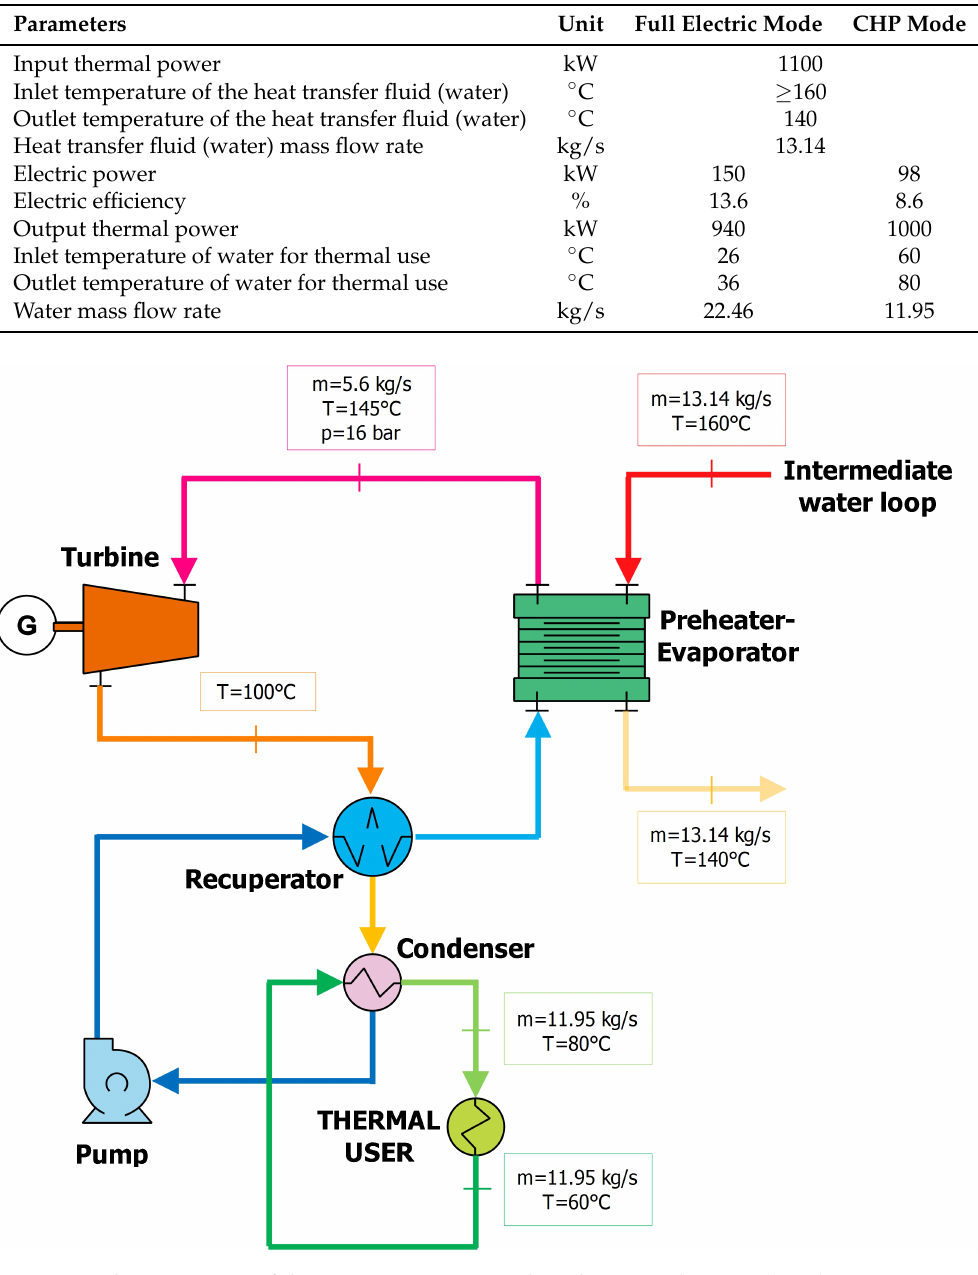
Table 1. Main features of the Organic Rankine Cycle (ORC) module at design conditions.